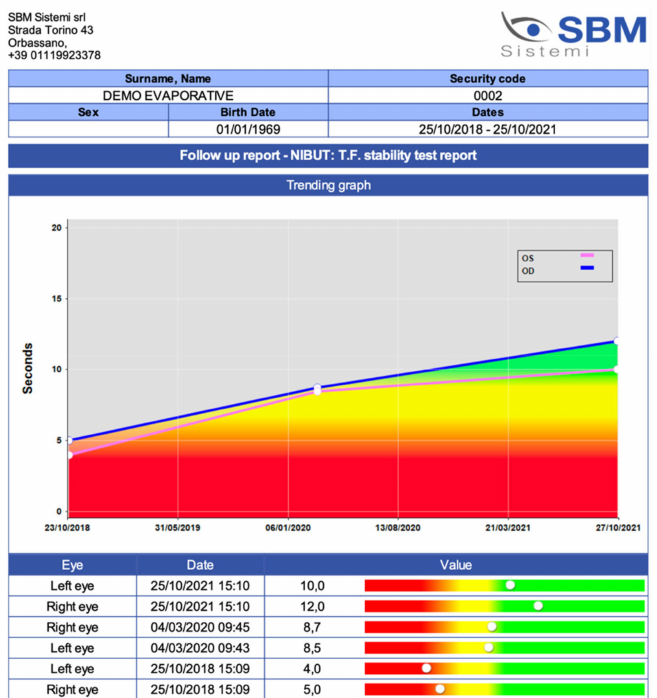
Figure 3. Trending graph obtained with the use of IDRA (Sbm Sistemi, Inc., Torino, Italy) related to noninvasive break-up time values collected at different time